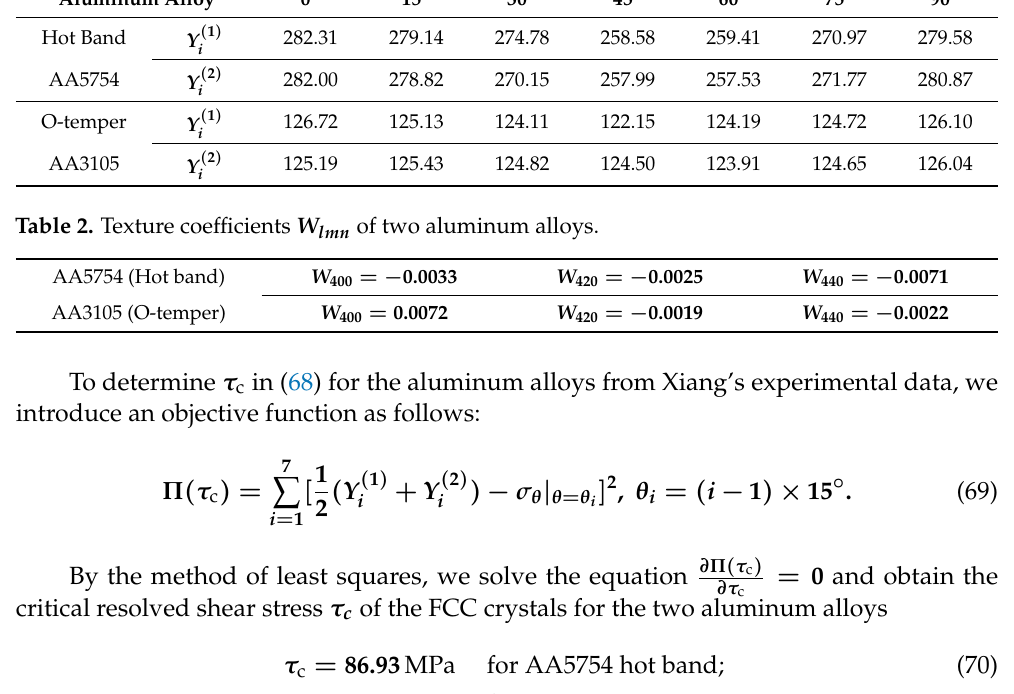
Table 1. Flow stresses Y